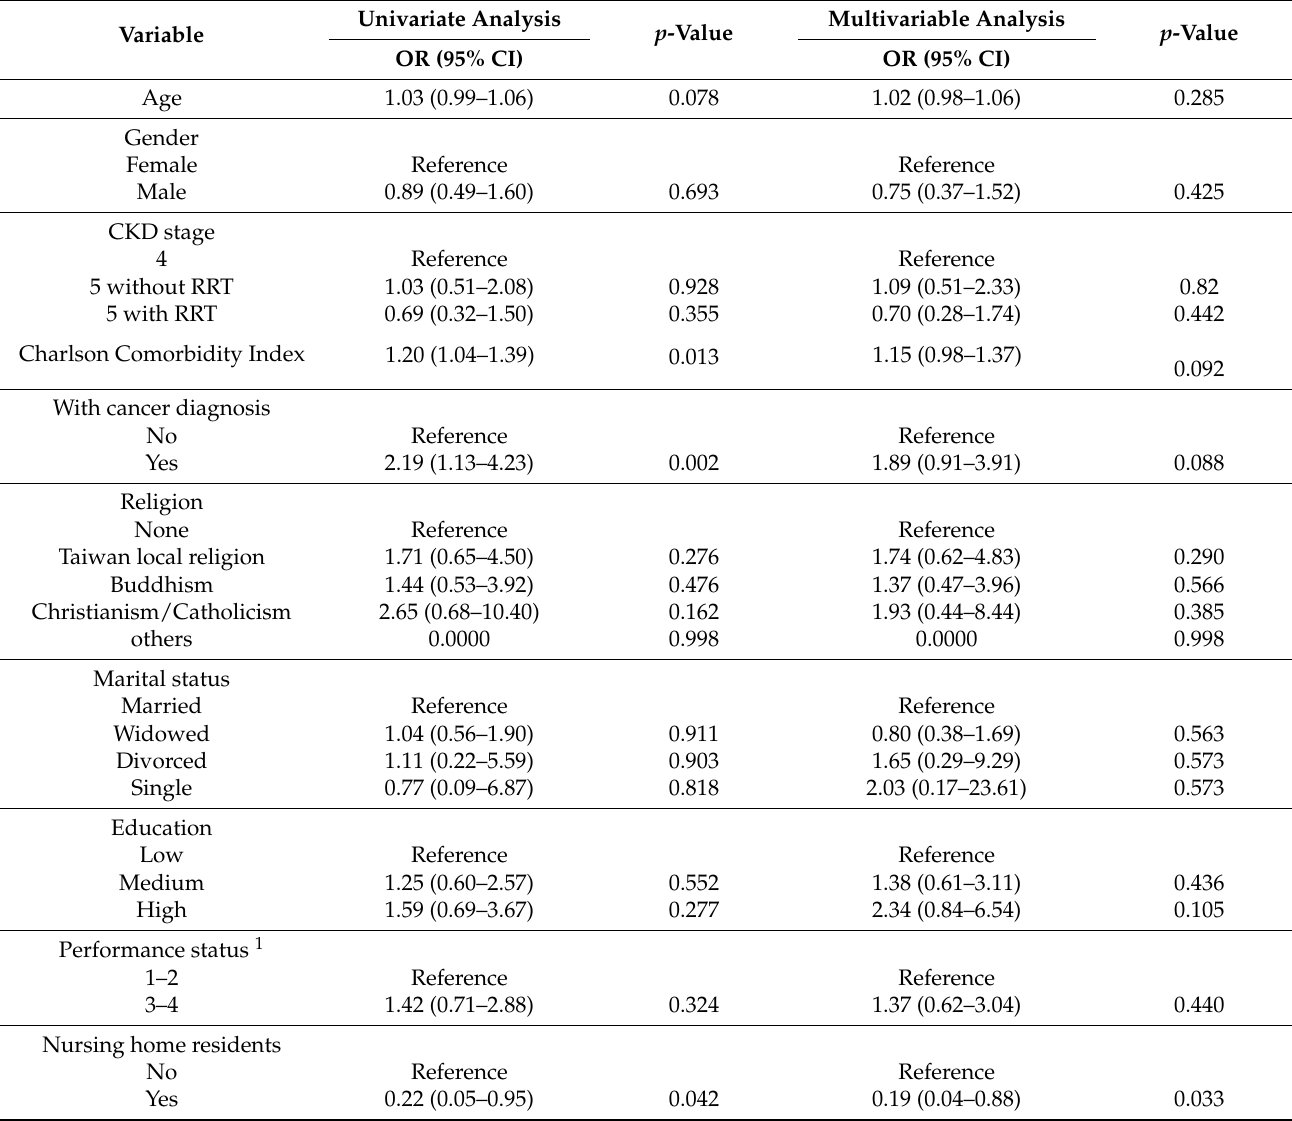
Table 2. Factors related to do-not-resuscitate consent signed by patients themselves in patients with advanced kidney disease.